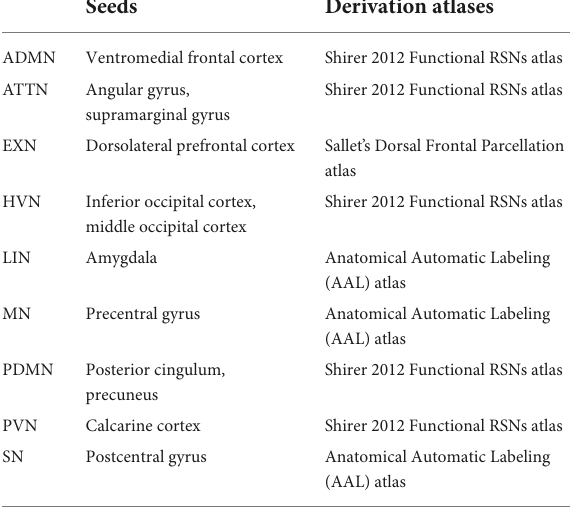
TABLE 1 Selected ROIs for the analysis.